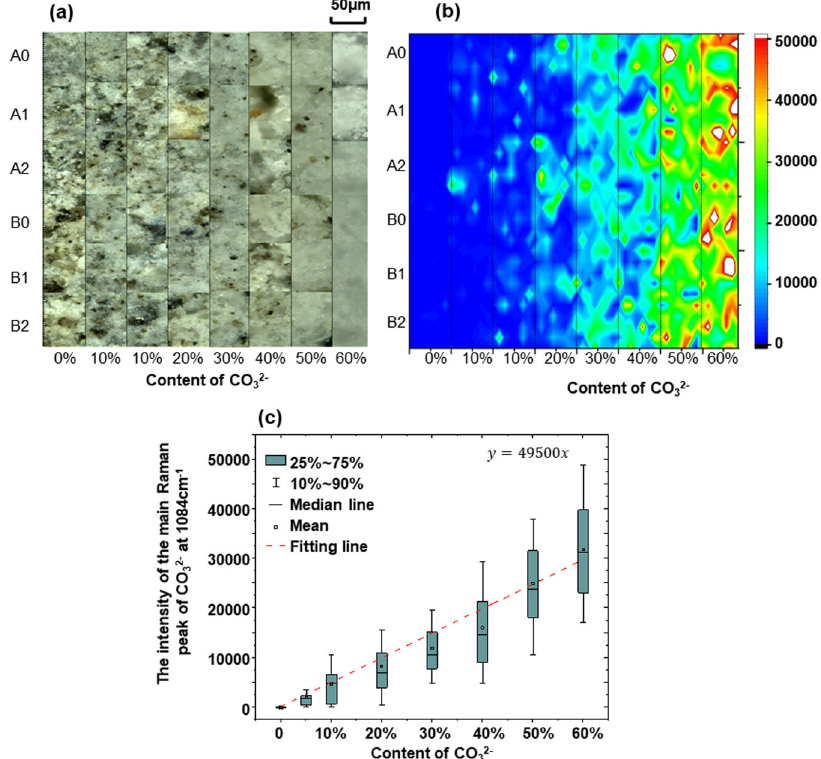
Fig. 2 Experimental results of the Raman spectroscopy measurements on the surface of the type (1) samples. a Appearance of test areas under optical microscope. b Mapping results of intensity of the 1084 cm − 1 Rama peak ( c ) Box chart of Raman peak intensities against content of CO 32 − and the fi tting